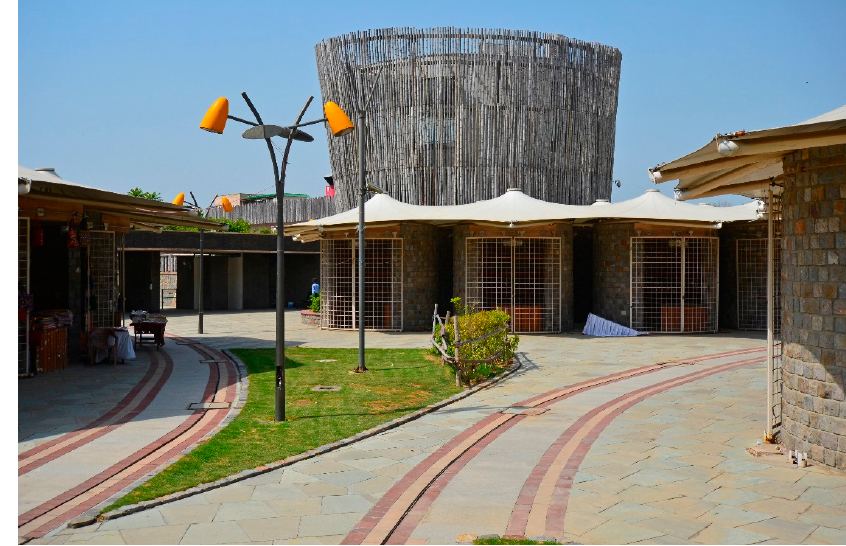
Figure 37. Built-forms organised around paved allies and green patches at Dilli Haat (Photo: Author).